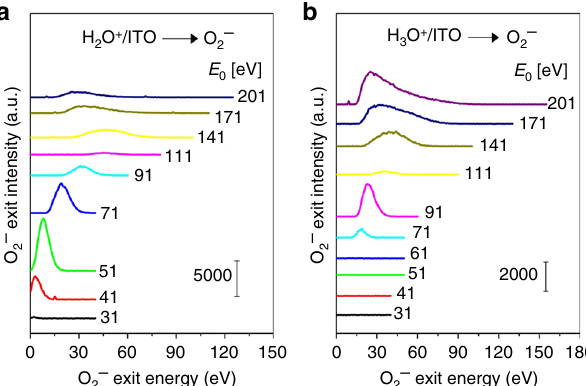
Fig. 1 Production of O 2 − from energetic H 2 O + and H 3 O + bombardment of ITO surfaces. Energy distributions of O 2 − scattered from a thick layer of conductive indium – tin oxide following bombardment by a H 2 O + and b H 3 O + ion beams at various incidence energies ( E 0 ). Scattering geometry: 45° angle of incidence and 45° angle of exit. The ITO layer was deposited on a Cu sample by magnetron sputtering of a commercial high-purity ITO